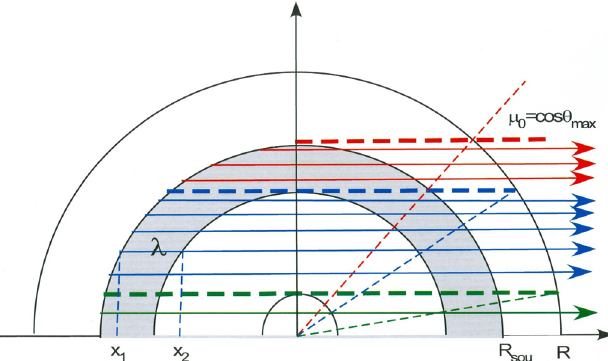
Fig. 9. 1-D spherical ray tracing. The g source is in the shaded shell.